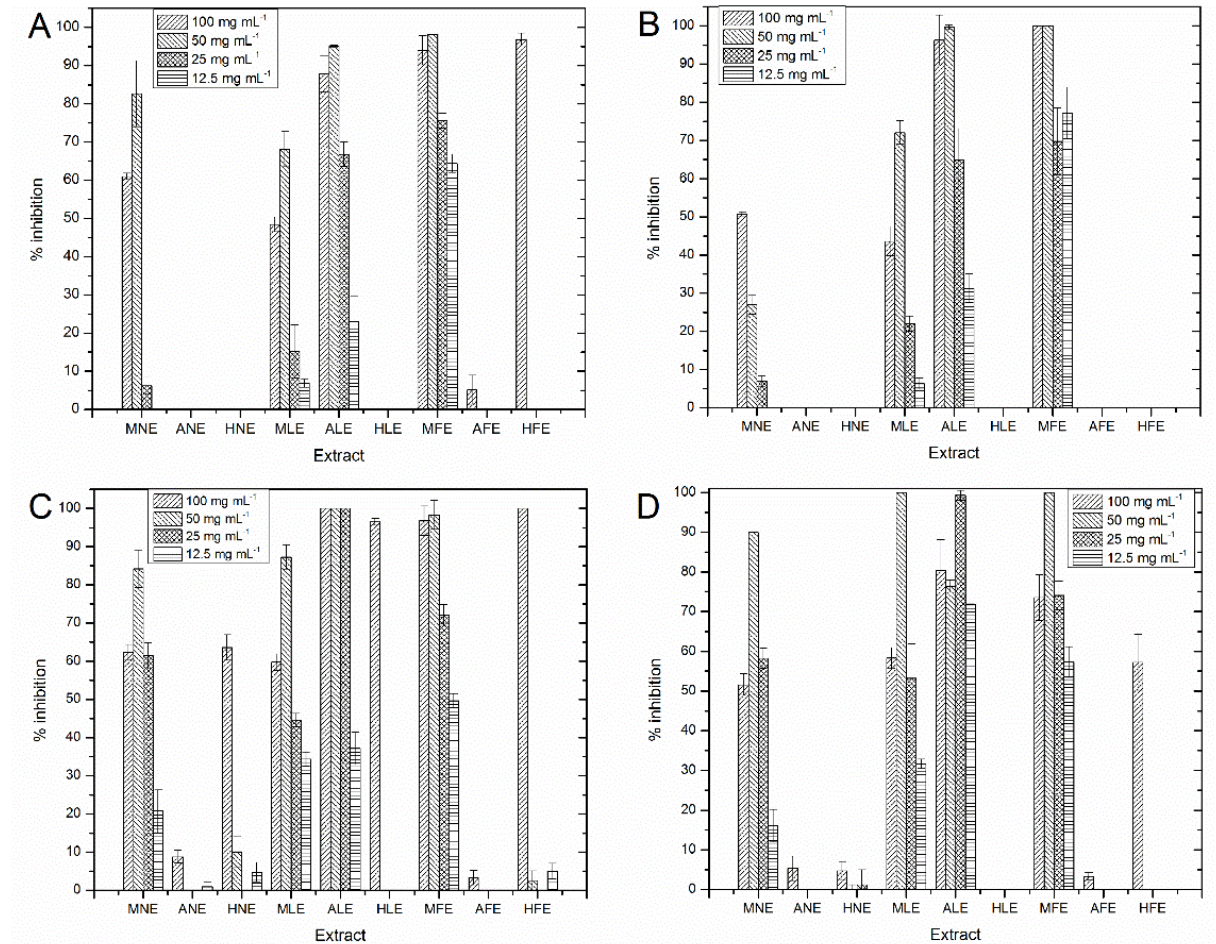
Figure 1. Inhibition percentage of the extracts at different concentrations against ( A ) V. parahaemolyticus ; ( B ) V. harveyi ; ( C ) P. damselae ; ( D ) P. leiognathi.